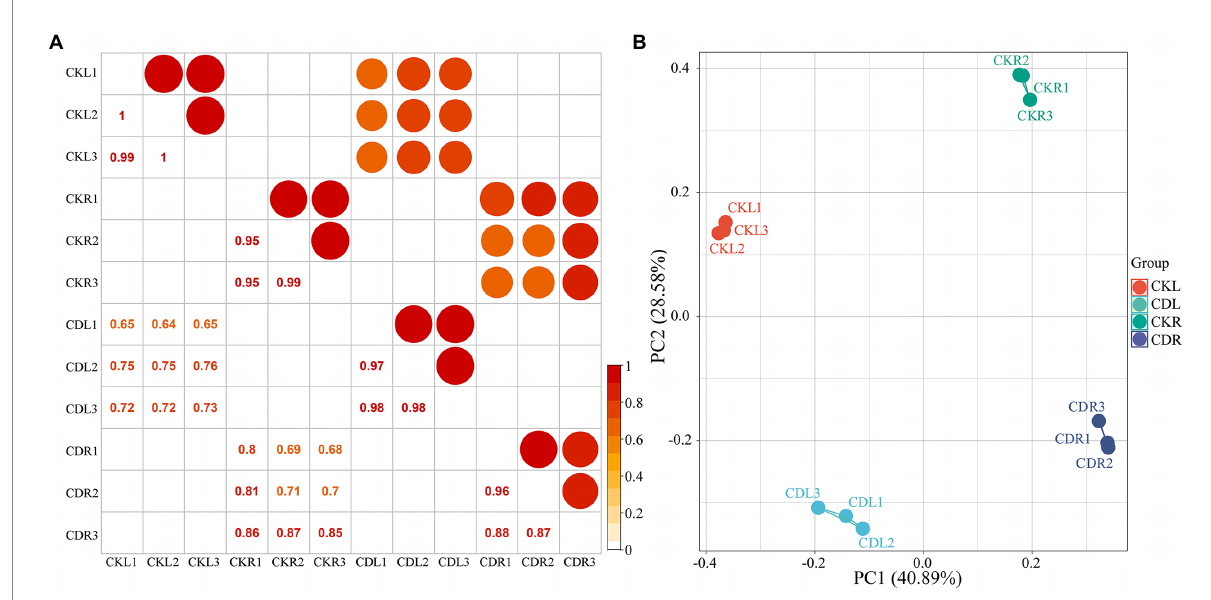
FIGURE 2 Pearson correlation (A) and principal component analysis (B) among 12 samples. CKL, leaf control groups; CKR, root control groups; CDL, PEG + cold treated leaf groups; CDR, PEG + cold treated root groups. The red background represents a high correlation